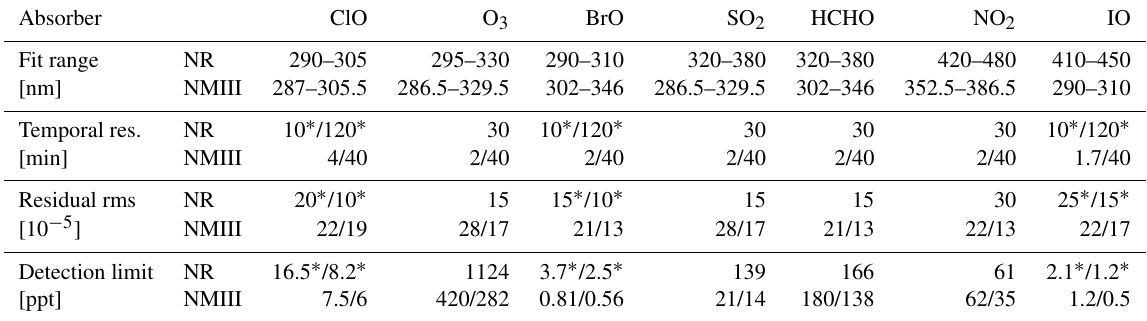
∗ The halogen-containing molecules were not fitted in the measurements from the Nördlinger Ries, as their presence was not expected. Instead, the respective spectral regions were summed up for 10 min and 2 h and the attained residual rms values were used to estimate upper limits for the detection limits of these trace gases. See Appendix E for details.